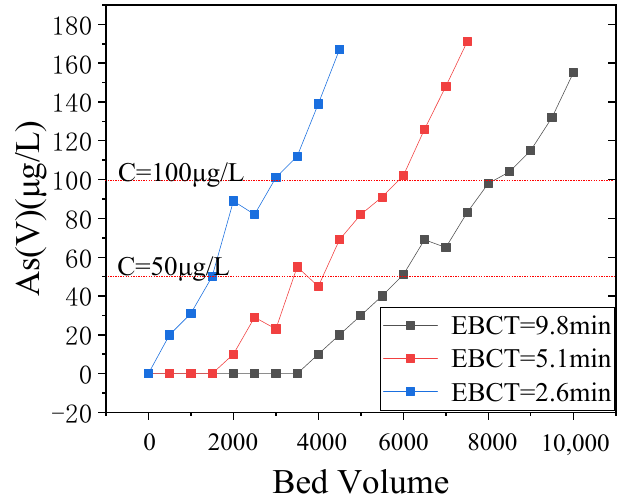
Figure 4. Effect of EBCT on As(V)